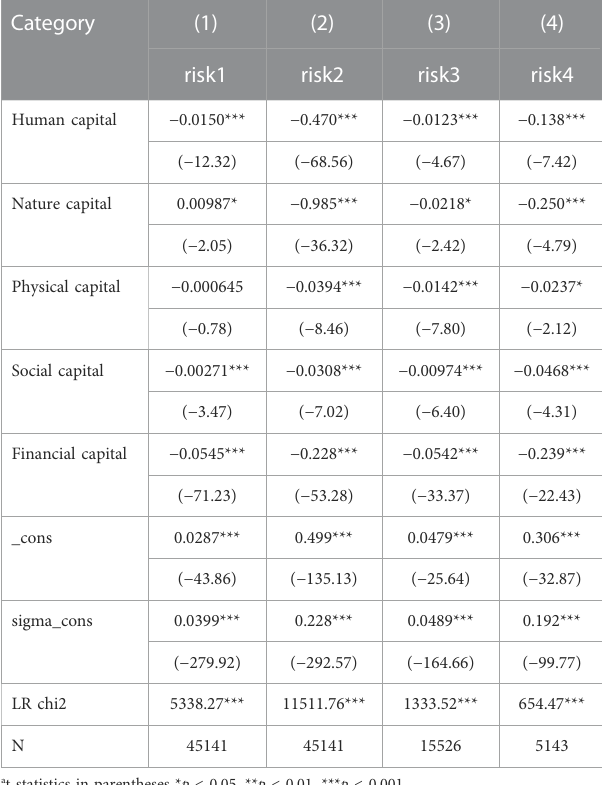
TABLE 6 Tobit regression estimates of natural capital variables to re-poverty